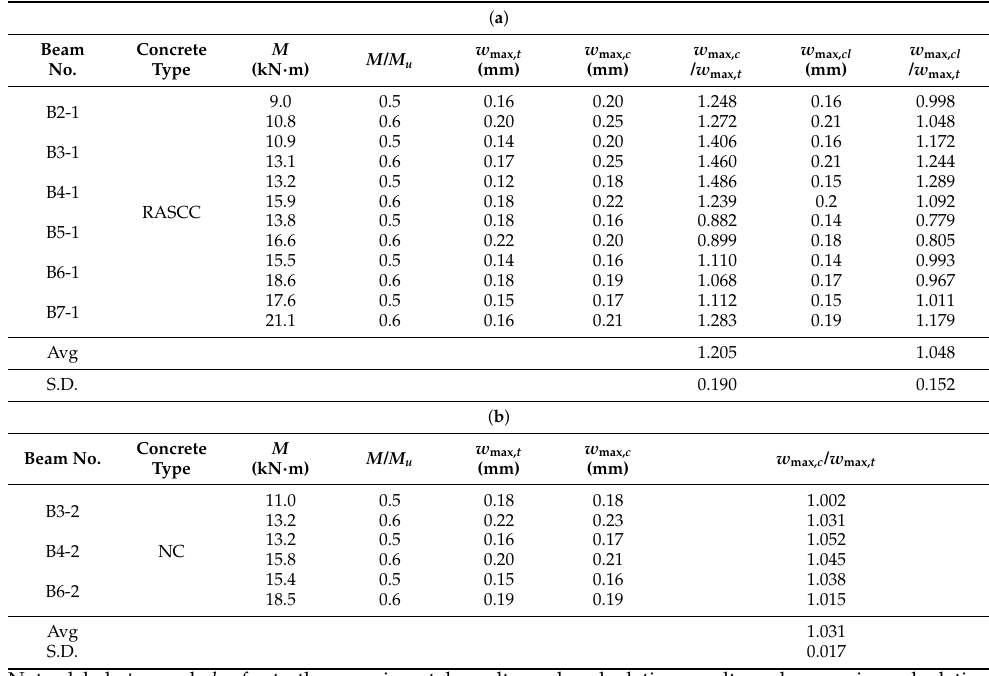
Table 7. ( a ). Comparison of the experimental and calculation results for crack width of RASCC beams. ( b ). Comparison of the experimental and calculation results for crack width of NC beams. ( a ) Beam